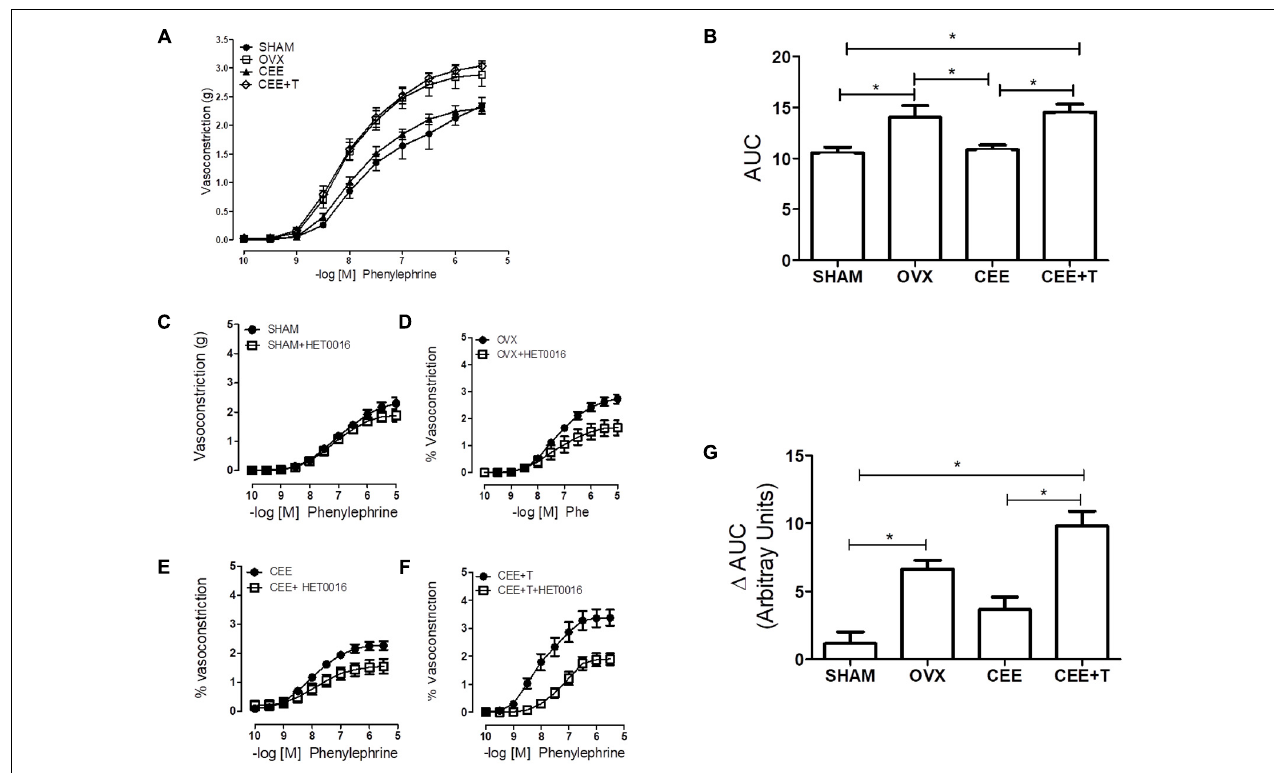
FIGURE 2 | Cumulative Concentration-Response Curves (CCRC) to phenylephrine (Phe) (A) and area under curve (AUC) to Phenyl (B) , in endothelium-intact aorta from SHAM, ovariectomized (OVX), OVX treated with conjugated equine estrogens (CEE) and OVX treated with CEE plus testosterone (CEE+T) female spontaneously hypertensive rats. CCRC to Phenyl in the presence of HET0016, the CYP4A and CYP4F inhibitor, in aorta from SHAM (C) , OVX (D) , CEE (E) , and CEE+T (F) rats. Difference of AUC in the absence and presence of HET0016 (G) . Results represent the mean ± SEM from 6 to 8 independent experiments. ∗ P <